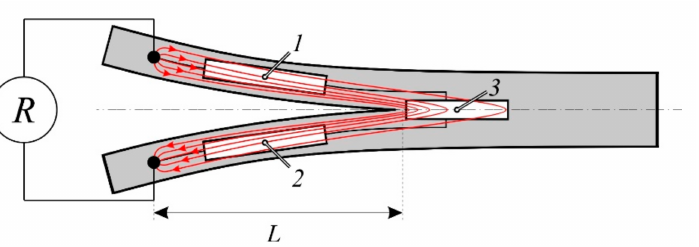
Figure 17. Schematic representation of DCB specimen during the Mode I interlaminar fracture toughness test. L is the distance from connected electrodes to the tip of the crack. Sections 1 , 2 , and 3 represent the resistive volume of the specimen as sequentially connected resistors, and red lines schematically show the current